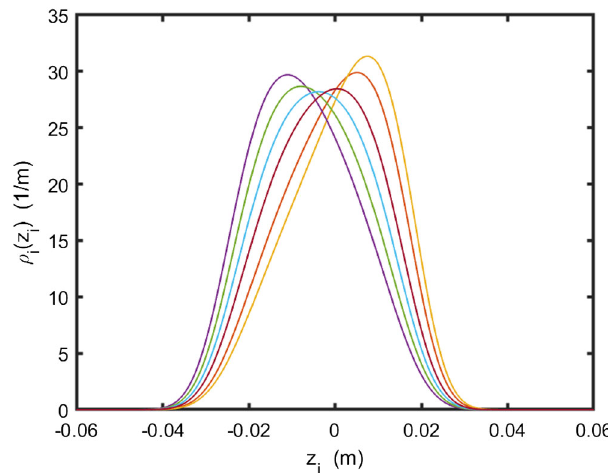
FIG. 20. Two bunches in fill C2 with HHC and its higher order ¼ 500 mA. mode. I av